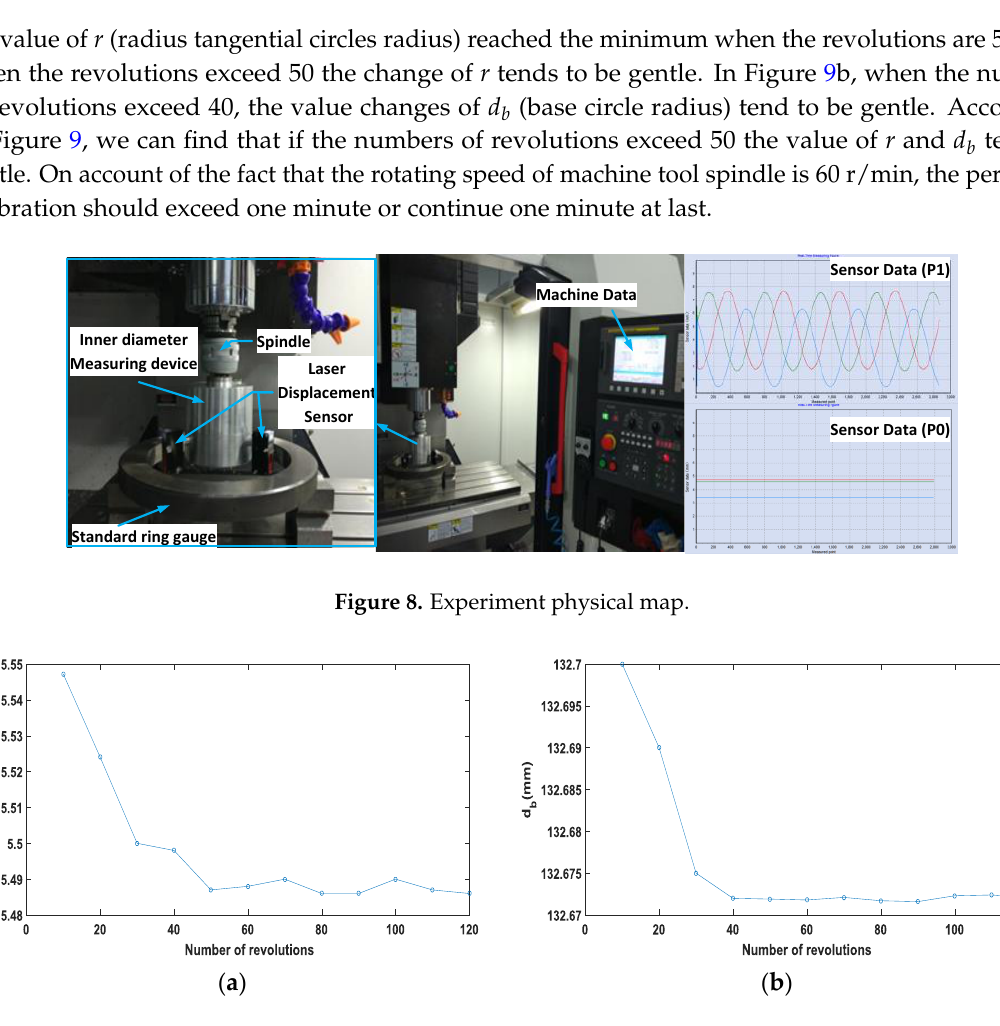
Figure 9. ( a ) The number of revolutions and r ; ( b ) The number of revolutions and d b .